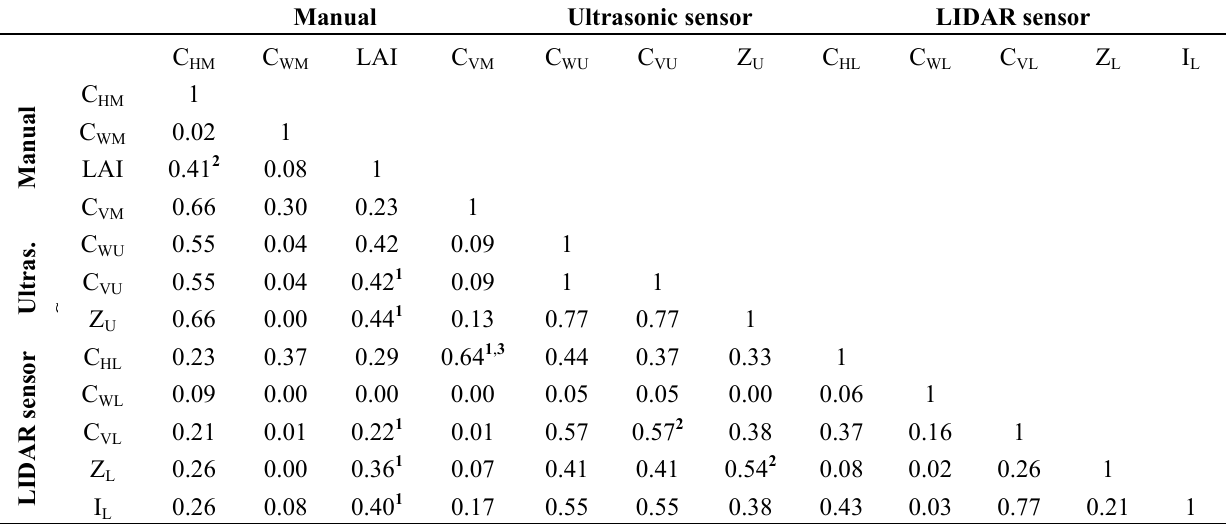
Selection criteria: 1 interesting relationship; 2 rational relationships; 3 good correlations is